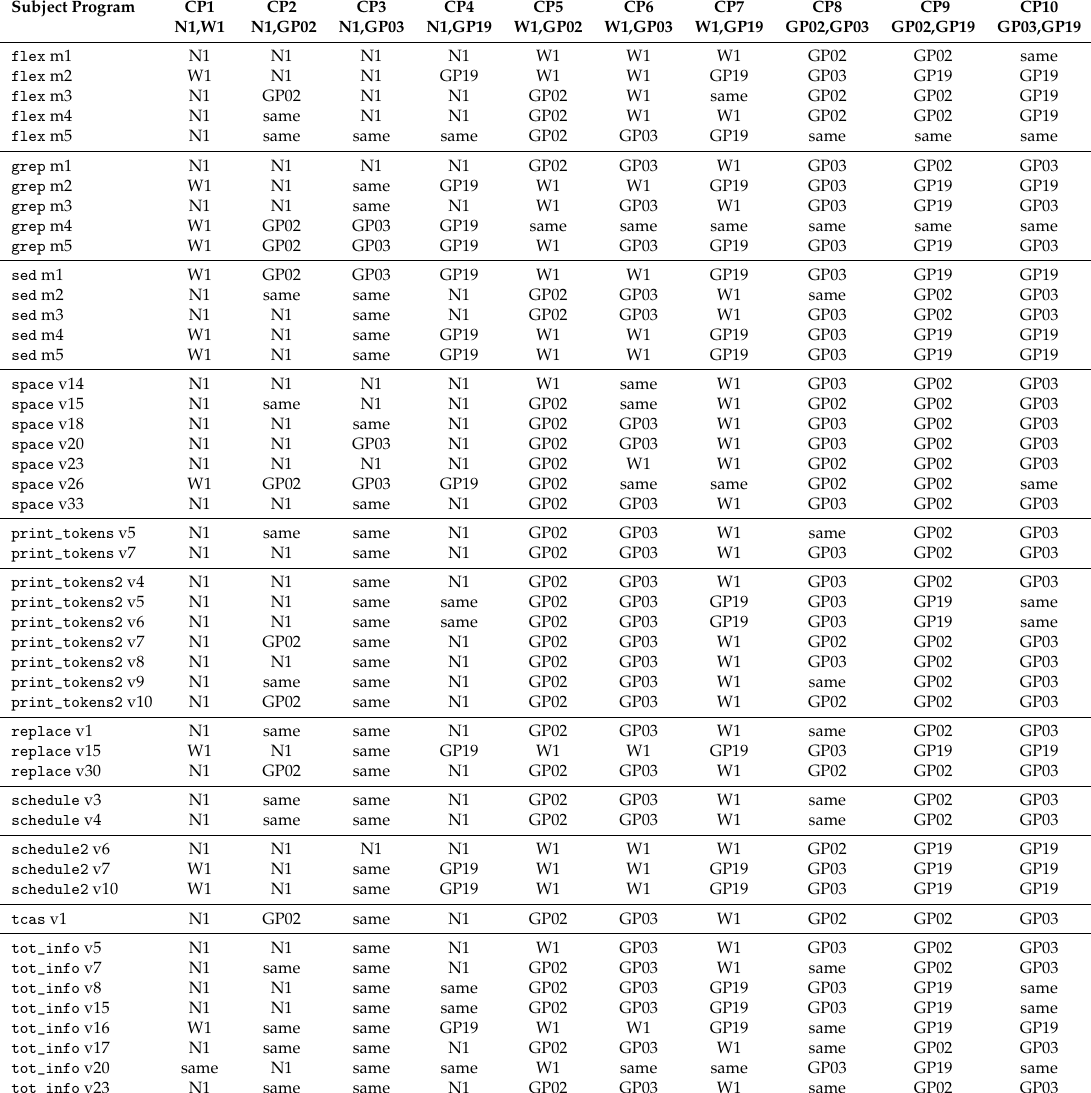
Table 3. Performances of various comparisons of the five maximal